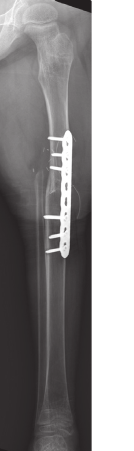
Figure 3: Postoperative anteroposterior radiograph shows resec- tion of the distal femur with Van Nes